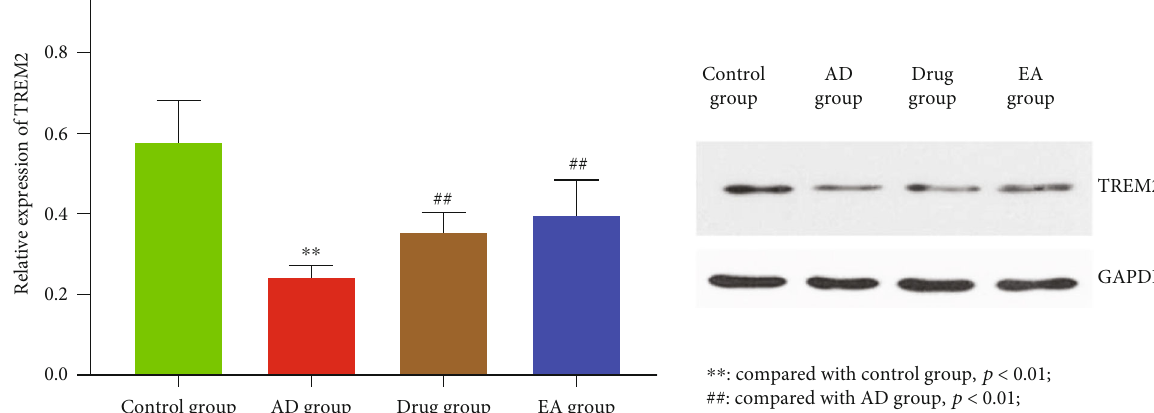
Figure 4: Results of the Western blotting test (in the hippocampus; 7 samples of each group). The relative expression of TREM2 for each mouse group revealing that electroacupuncture may signi fi cantly increase the expression of TREM2 in the hippocampus ( p = 0 : 001 < 0 : 01